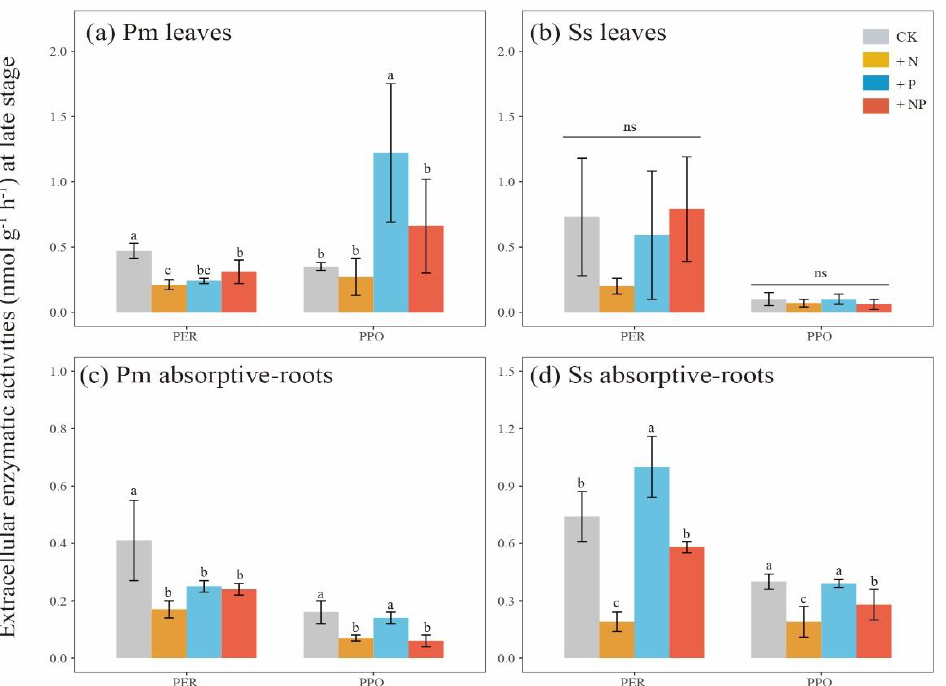
Figure 5. Activity of two microbial oxidase extracellular enzymes in four substrates under different treatments in the 3-year stage of decomposition. Values are the means ± SE ( n = 4). Significant differences between means were determined using Tukey’s honestly significant difference test. Different letters indicate significant differences among treatments ( p < 0.05). CK, control; +N, nitrogen addition; +P, phosphorus addition; +NP, combined additions of nitrogen and phosphorus; PER, peroxidase; PPO, polyphenol oxidase; Pm, Pinus massoniana ; Ss, Schima superba .